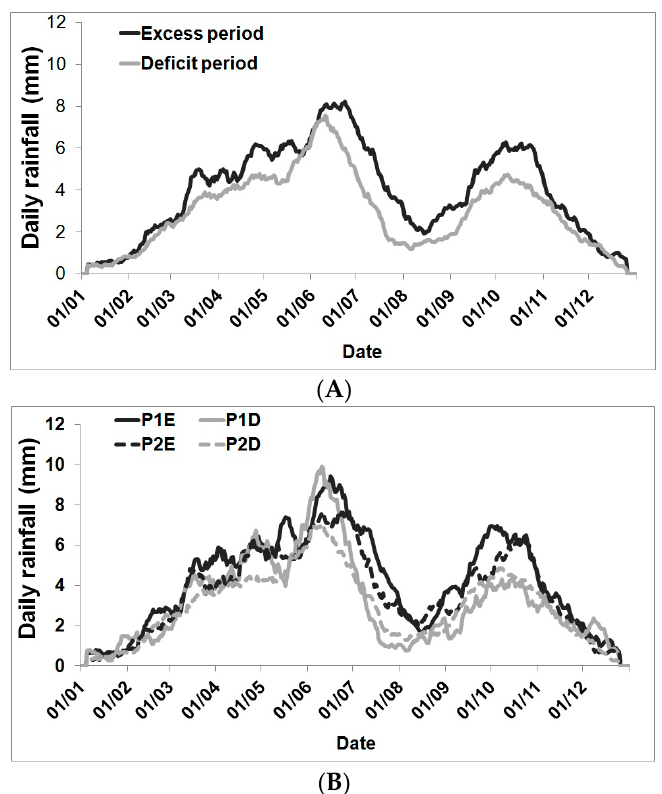
Figure 3. Average seasonal cycle composite: ( A ) Excess and deficit periods. ( B ) Excess (P1E: before 1968 and P2E: after 1968) and deficit (P1D: before 1968 and P2D: after 1968) in the Agneby watershed in Agboville.